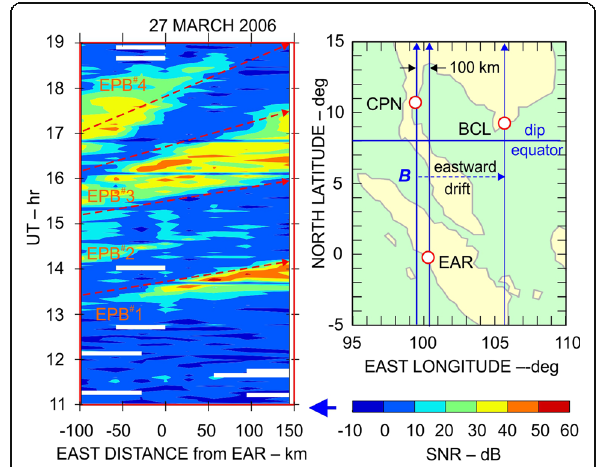
Fig. 14 (Left panel) The LTI plot showing the eastward drift of the plume of interest, observed with the EAR on 27 March 2006. (Right panel) Map showing geometry for EPB appearance to west of EAR, which is essentially over